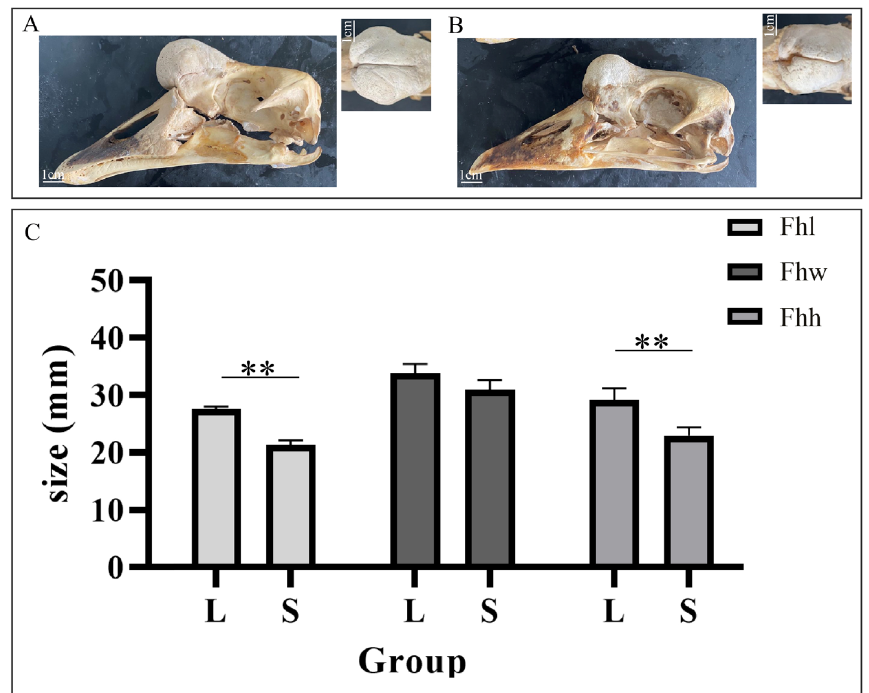
Figure 3. Frontal humps of Yangzhou geese with different anatomical knob sizes. ( A , B ) Differences were observed in the frontal hump size at 380 days of age between geese in the L ( A ) and S ( B ) groups. ( C ) Comparison of frontal humps of geese in the L and S groups. Significant differences are indicated with two asterisks ( P < 0.01). Fhl frontal hump length, Fhw frontal hump width, Fhh frontal hump height.